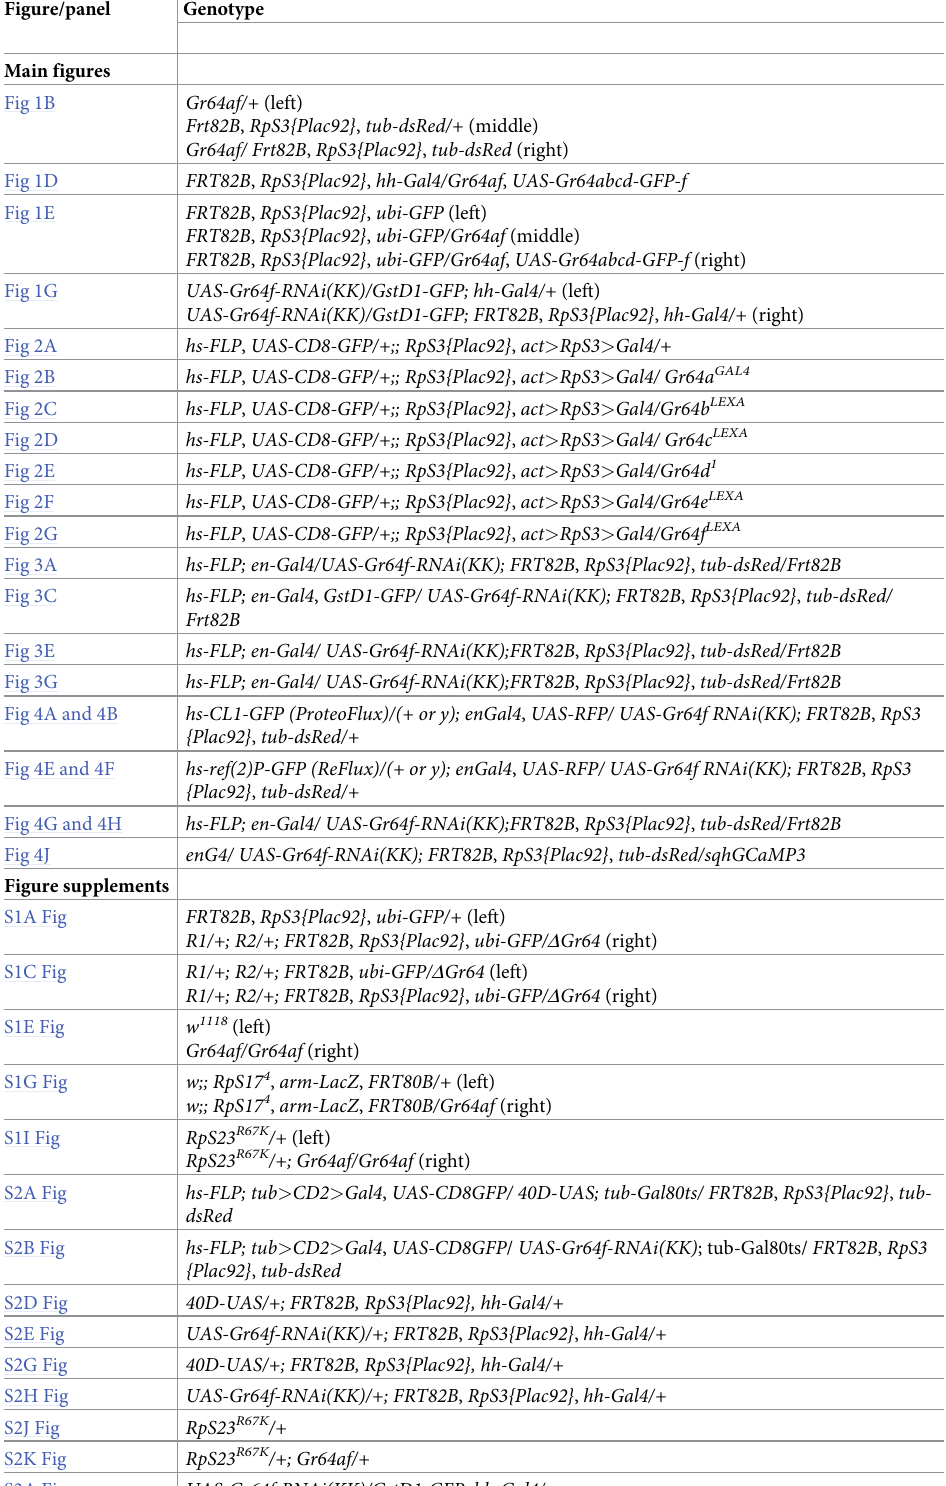
Table 1. Genotypes for all experimental